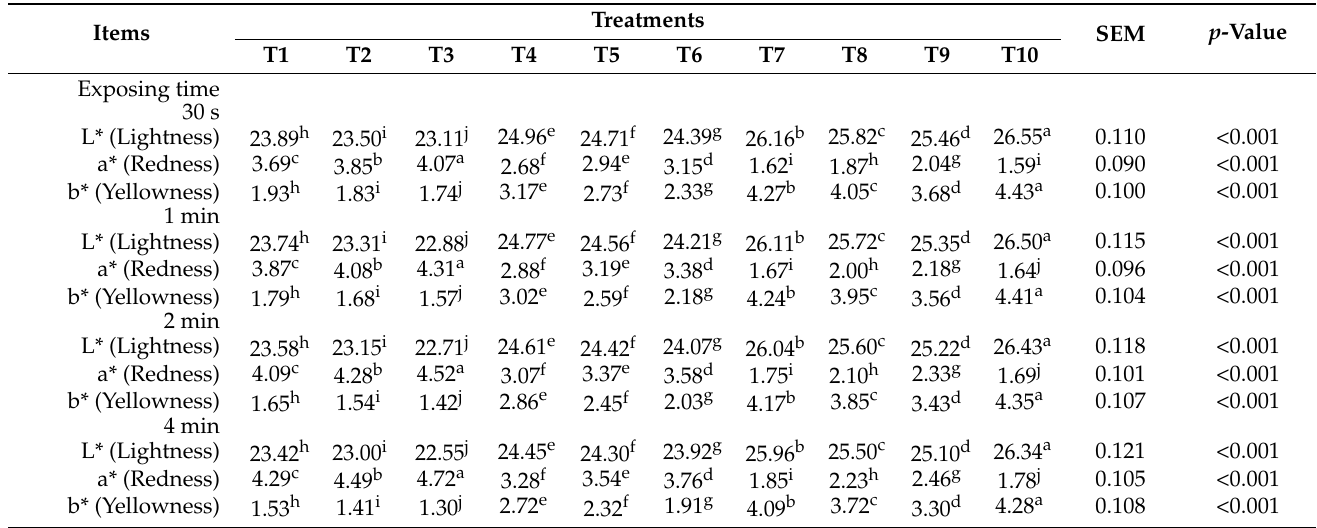
Table 2. Effect of high concentration levels of different gas exposing conditions on Myoglobin solution (n = 10).